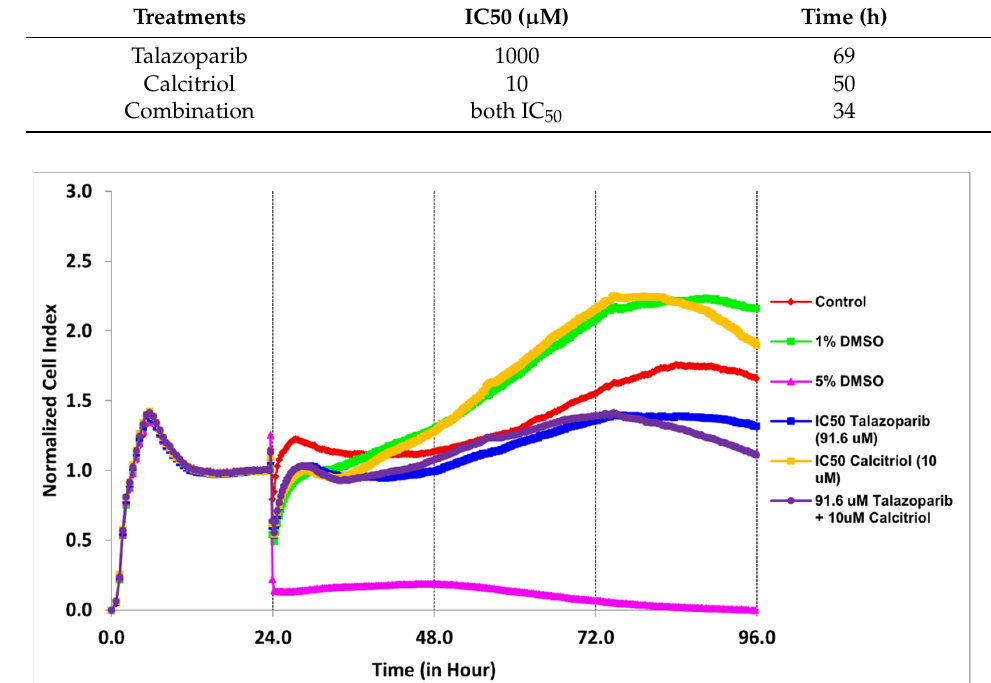
Table 2. The IC 50 concentration of talazoparib and calcitriol in the MDA − MB − 468 cell line and the relevant time points.